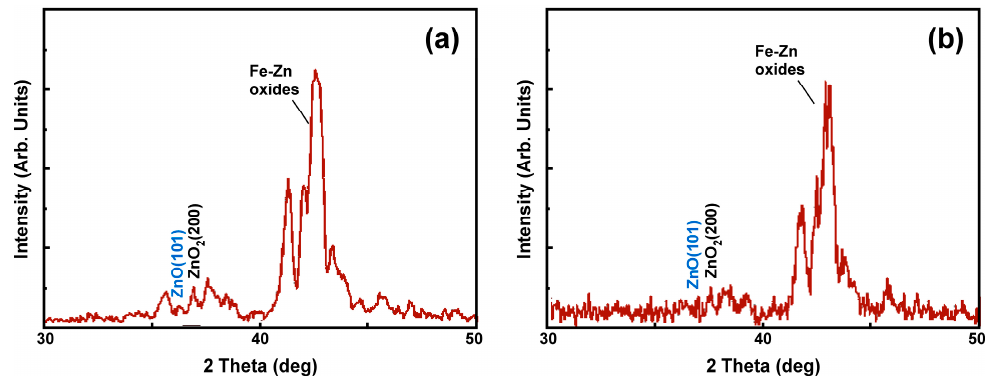
Figure 7. GI-XRD diffraction pattern of the samples grown using pack cementation with an incidence angle of ( a ) 5° and ( b ) 1.5°, respectively.